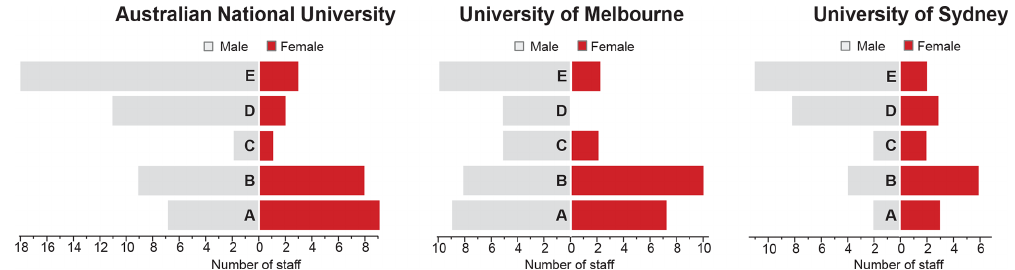
Figure 3. Staff profiles by headcount for three selected universities to exemplify high levels of gender inequity at Levels D (Associate Professor/Reader) and E (Professor) in geoscience in Australasian universities (see Table S1 for data of all the universities considered in this